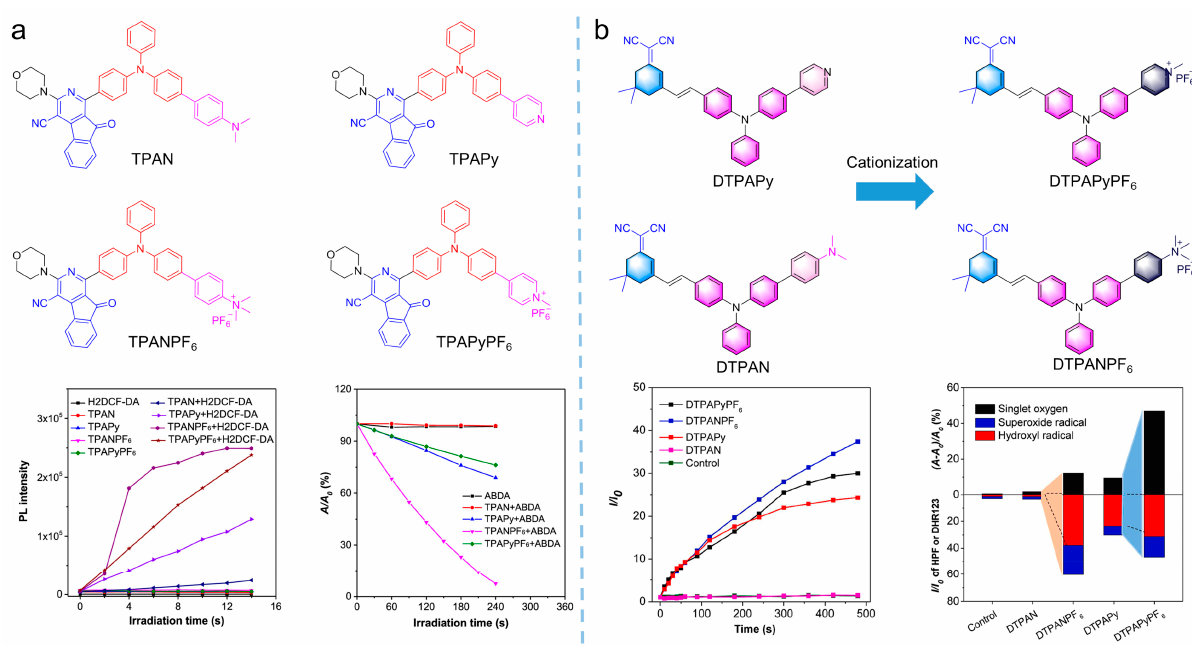
Figure 6. Cationic molecular engineering strategy to enhance ROS. ( a ) Molecular structure and ROS generation of TPAN, TPAPy, TPANPF 6 and TPAPyPF 6 indicated by H2DCF-DA and ABDA. Reprinted with the permission of the authors of [43]. Copyright 2019, American Chemical Society. ( b ) Molecular structure, ROS generation of DTPAPy, DTPAN, DTPAPyPF 6 , and DTPANPF 6 indicated by HPF or DHR123, and summary of different ROS generation of photosensitizers. Reprinted with the permission of the authors of [44]. Copyright 2022, Elsevier.